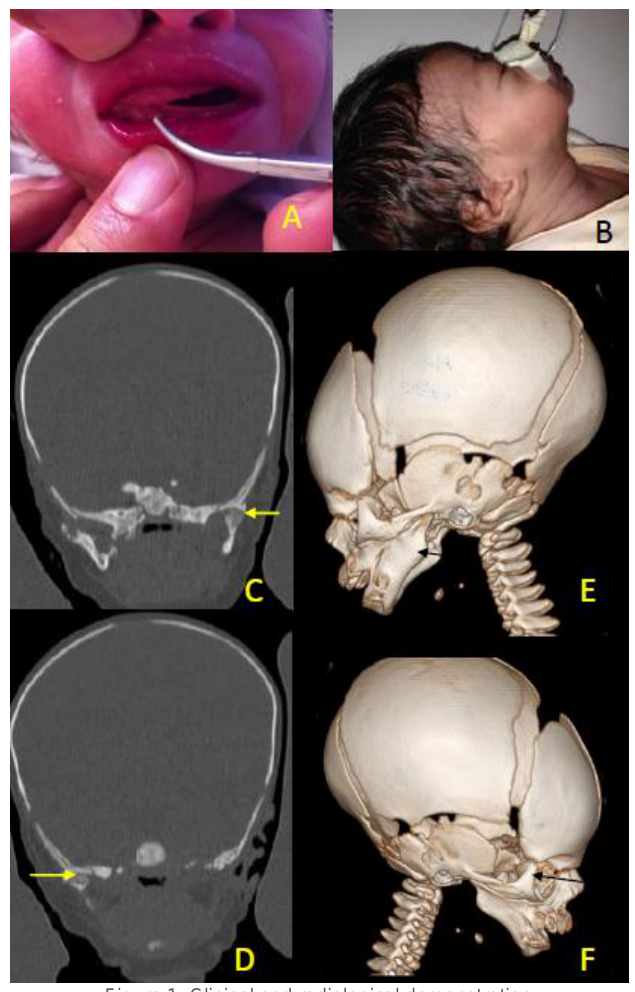
Figure 1: Clinical and radiological